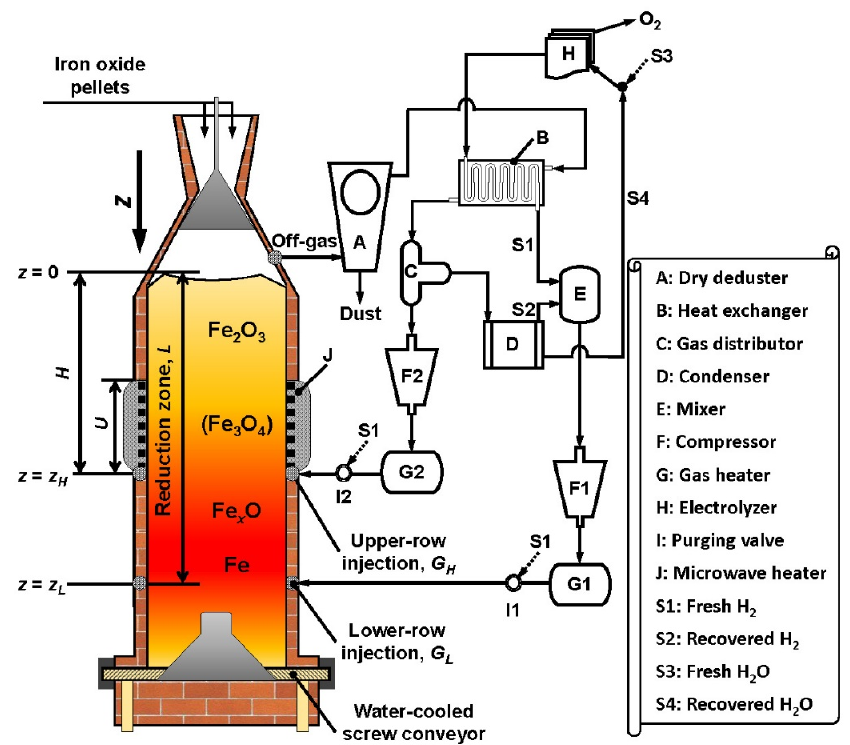
Figure 1. Schematic of the H 2 -SF with a microwave heater and configuration of the dual-row injection TGR system.